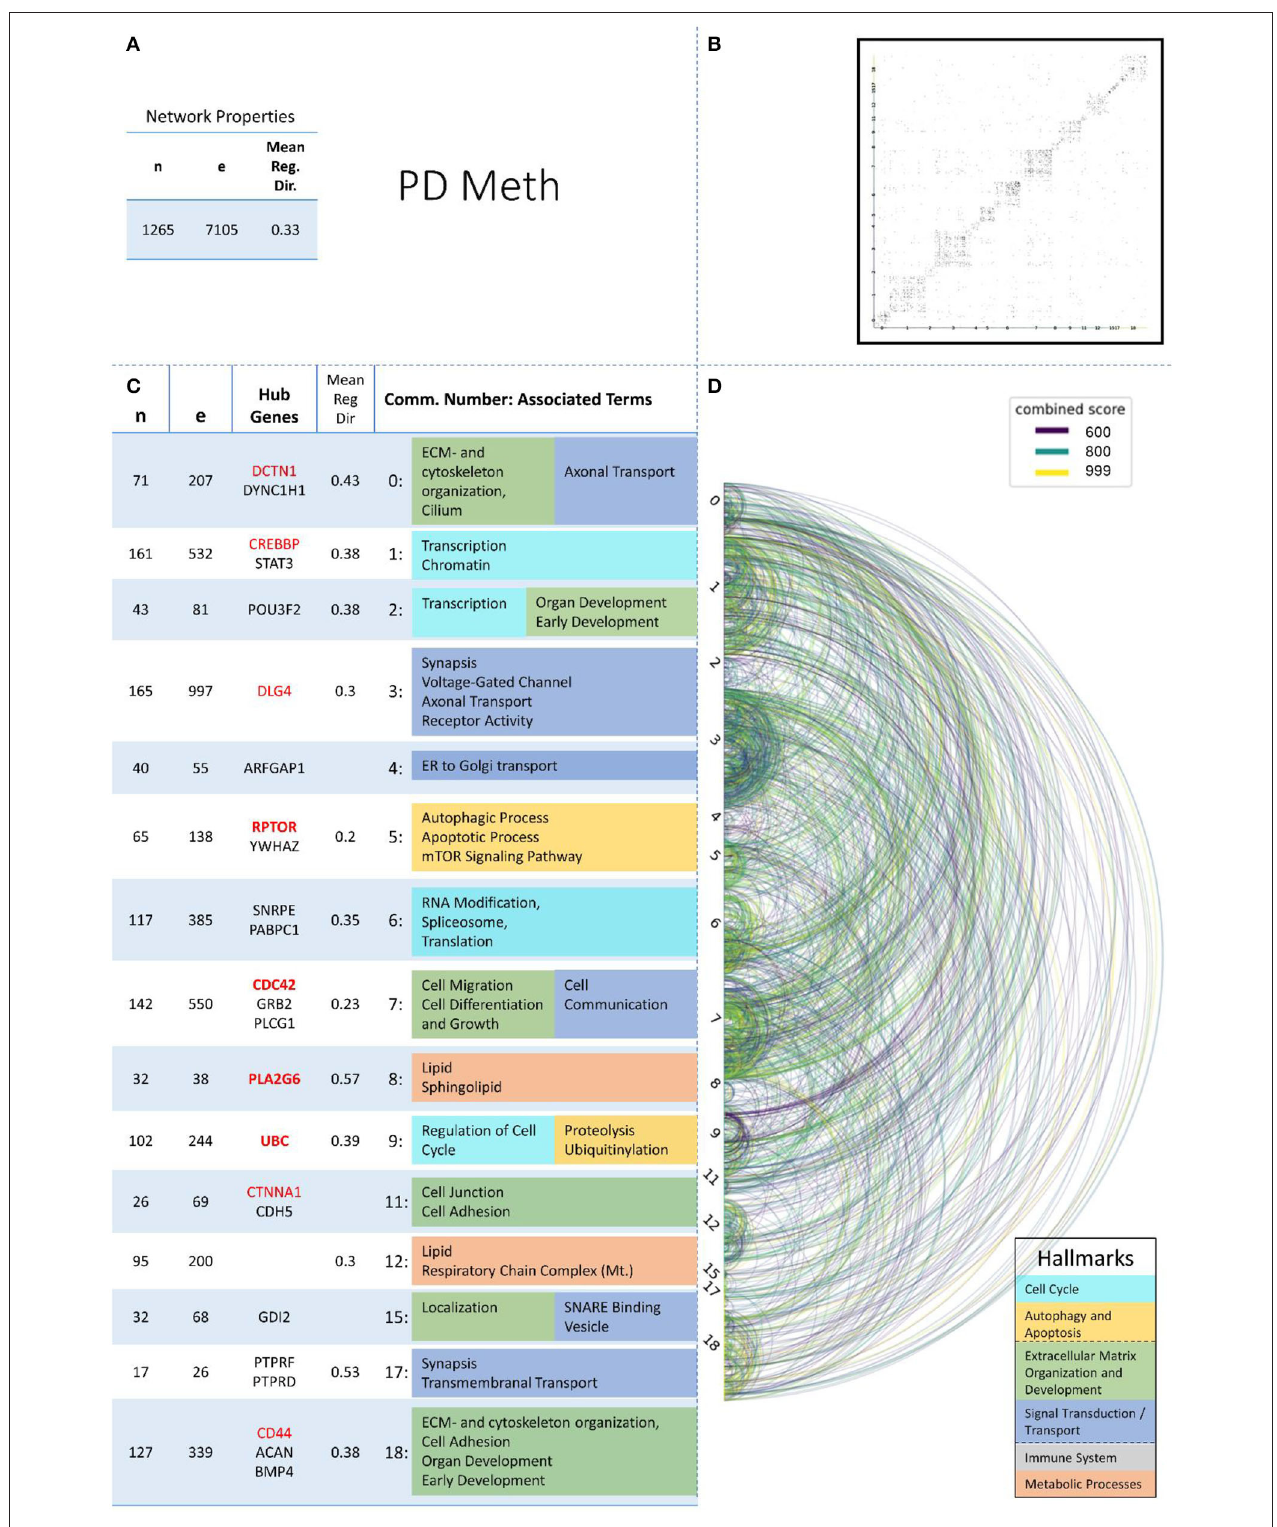
FIGURE 6 | Summarizing figure of the network analysis results of the methylomic layer of PD. The general properties, such as number of nodes (genes) and edges (a combined score > 400 between two nodes) of the PPI network constructed with all PD methylomic genes, are given in Subfigure (A) . The individual